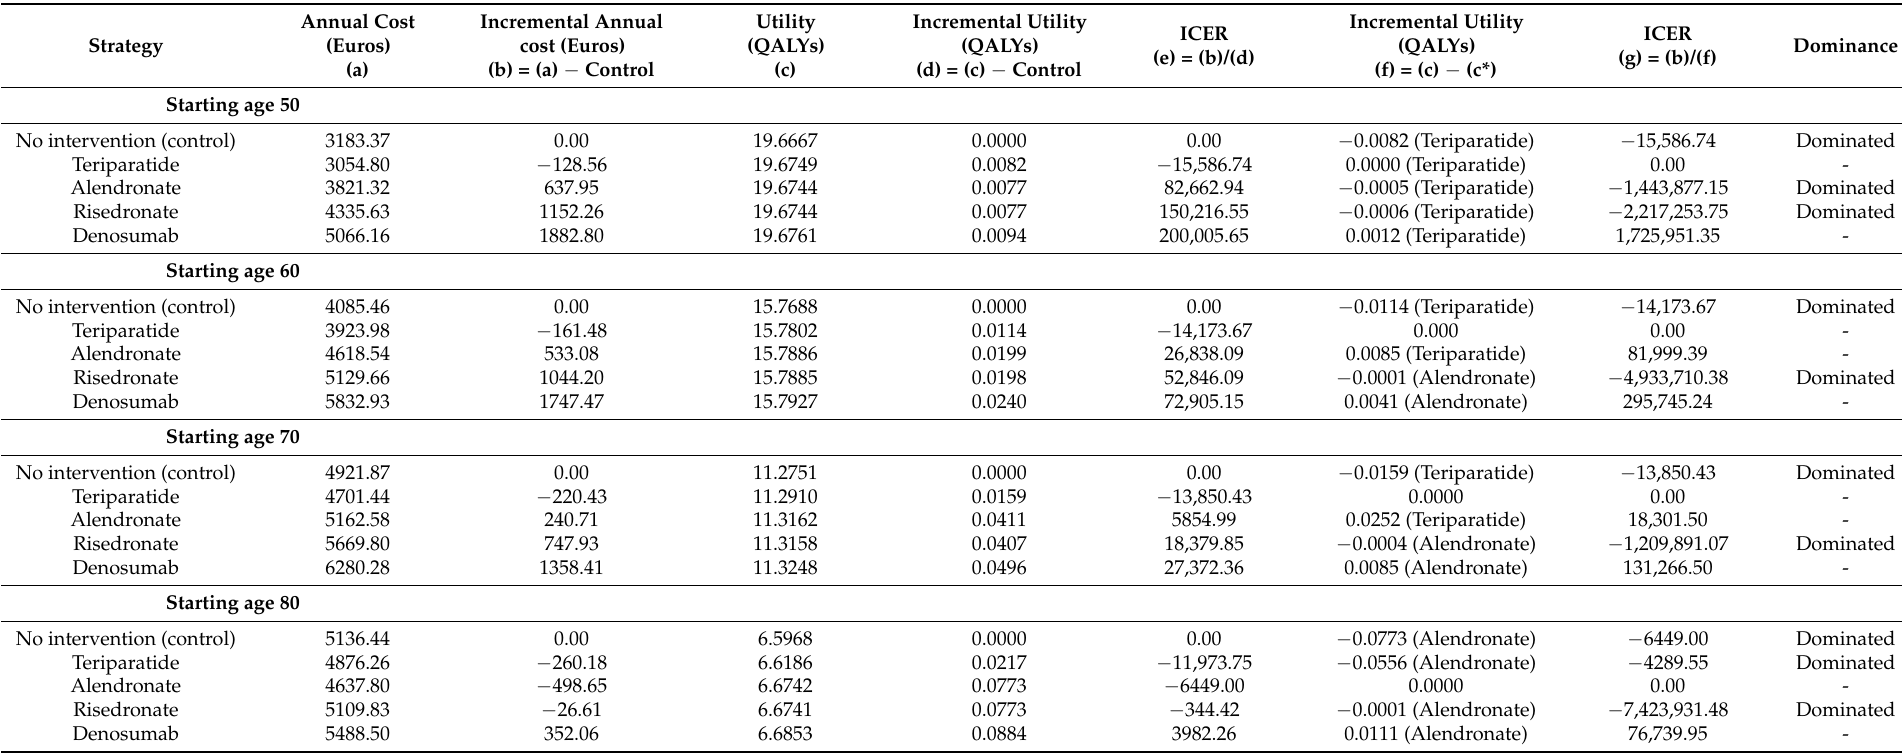
Table 7. The ratio of the increment in cost over the increment in effectiveness (ICER) for the 4 drugs compared with non-intervention and with each